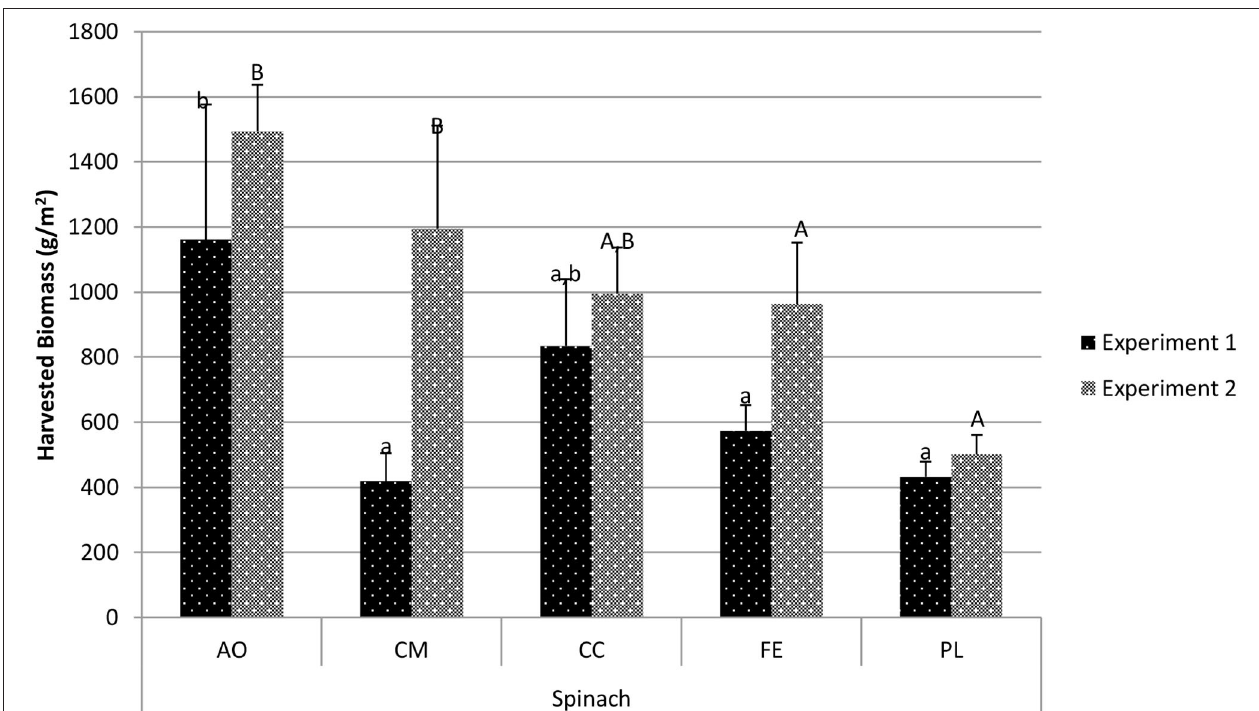
FIGURE 4 | Comparison of spinach harvested biomass between treatments in experiment 1 and experiment 2. Data shown are mean ± standard deviation for two different replicate experiments. Significant differences among mean values are indicated with different letters above bars ( p < 0.05) with lower-case letters for experiment 1 and capital letters for experiment 2. Results analyzed using ANOVA Tukey HSD for significance testing.